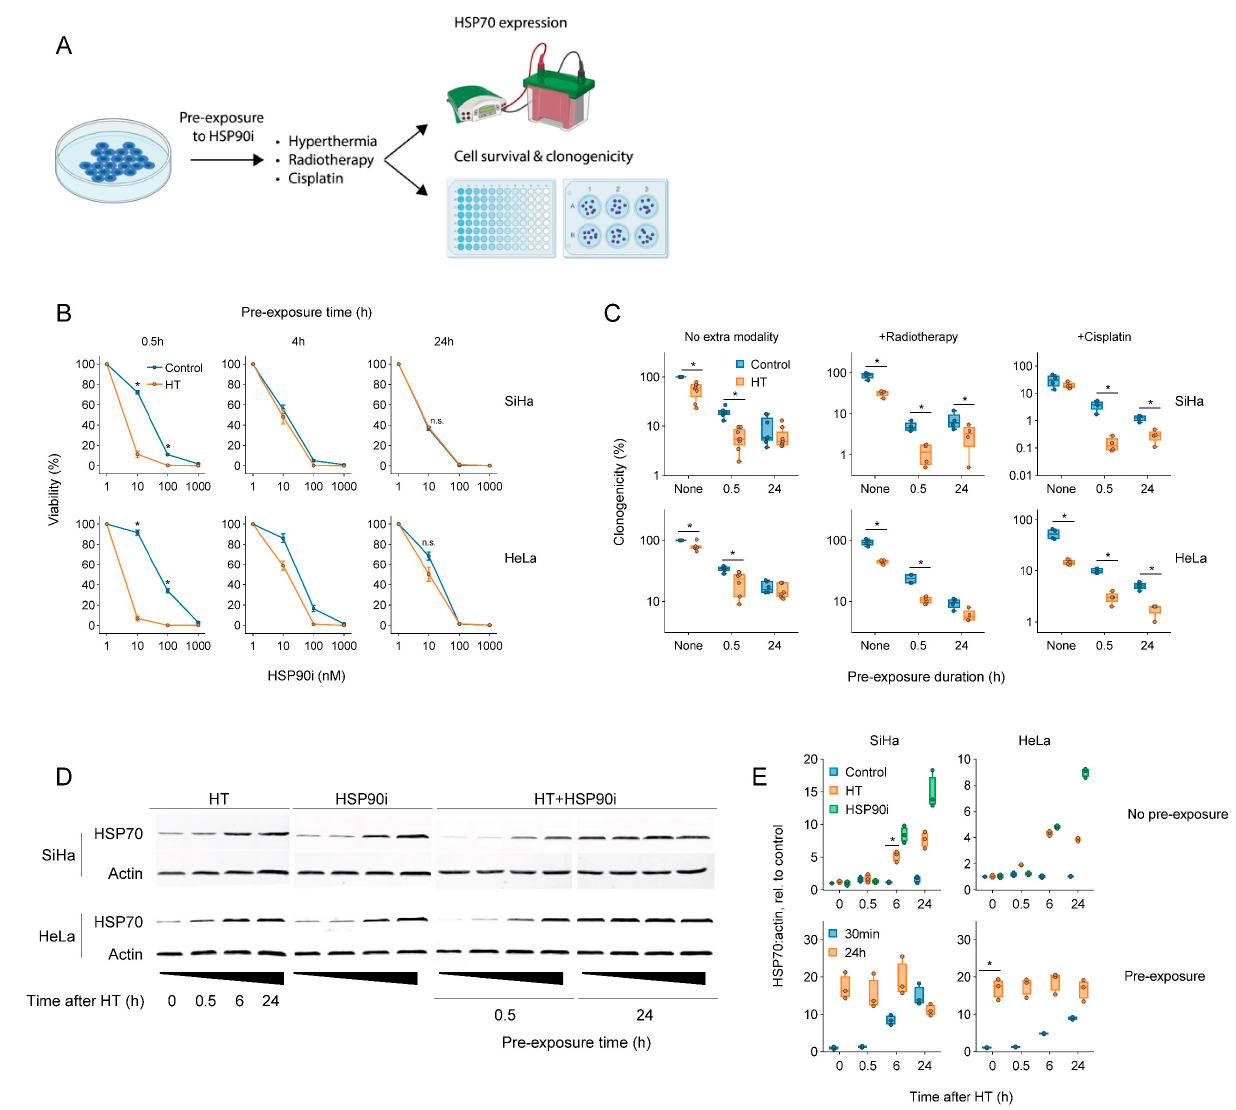
Figure 1. Short pre-exposure to ganetespib maximizes the radio- and chemo-sensitization by hyper- thermia. ( A ) Experimental setup. Cervix cancer cells were pre-exposed to ganetespib (HSP90i) for different durations and treated with different combinations of hyperthermia (HT), 3.3 µ M of cisplatin and 2 Gy of radiotherapy. ( B ) Cell viability 72 h after treatment with HT and HSP90i. Noteworthy significant differences are marked with an asterisk. Not significant: “n.s.”. ( C ) Effect of pre-exposure with 30 nM of HSP90i on the clonogenicity after radio- and chemo-thermotherapy. ( D ) Immuno-blot showing levels of HSP70 and beta-actin (loading control) at various time points after HT and HSP90i. The uncropped blots are shown in Figure S3. ( E ) quantification of ( D ).